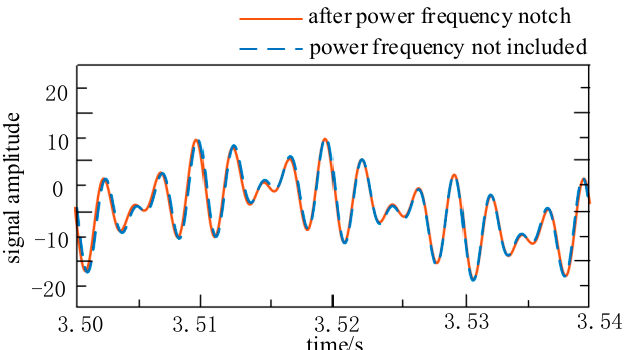
Figure 5. Comparison of the signal after the line frequency notch and the signal without the line frequency notch.